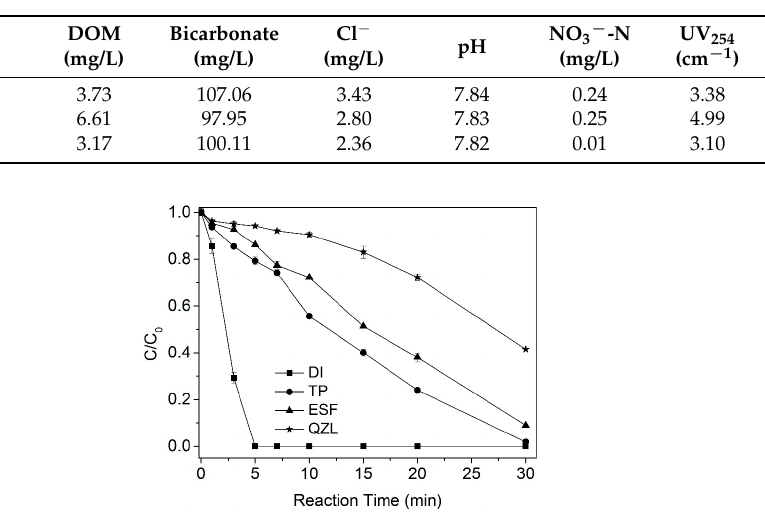
Table 2. Water quality of the waters collected from tap water (TP), Qizhen Lake (QZL) and effluent of sand filter (ESF).